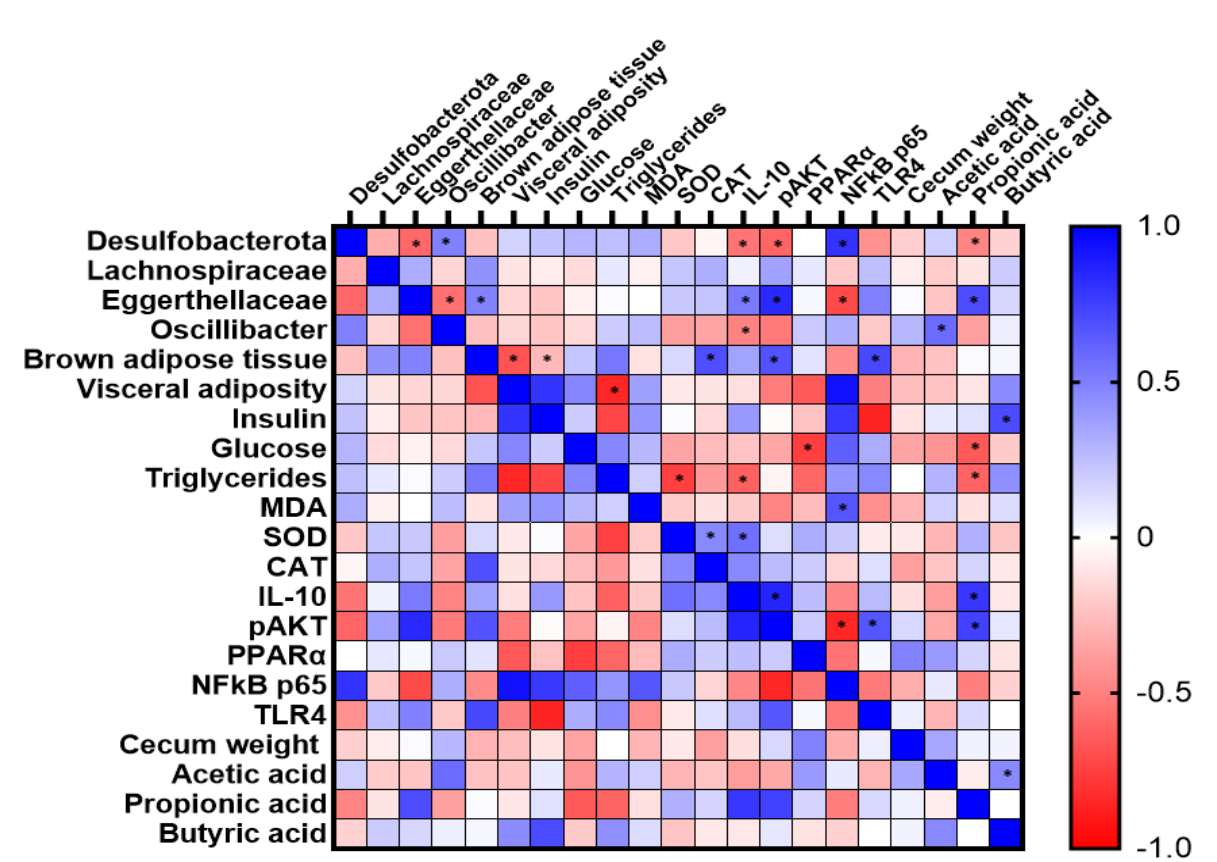
Figure 6. Heat map of Pearson’s correlations between markers of gut microbiota metabolism and markers of metabolic change after 10 weeks of treatment with germinated millet flour. Catalase (CAT); Interleukin 10 (IL − 10); Malondialdehyde (MDA); Nuclear factor-kappa B (NF κ B p65); phospho-protein kinase B (pAKT); Peroxisome proliferator-activated receptor alpha (PPAR α ); Superoxide dismutase (SOD); Toll-like receptor 4 (TLR4). n = 10/group. * p < 0.05. Data from chemical anal- yses, markers of inflammation and oxidative stress, and other markers of metabolic changes were previously published